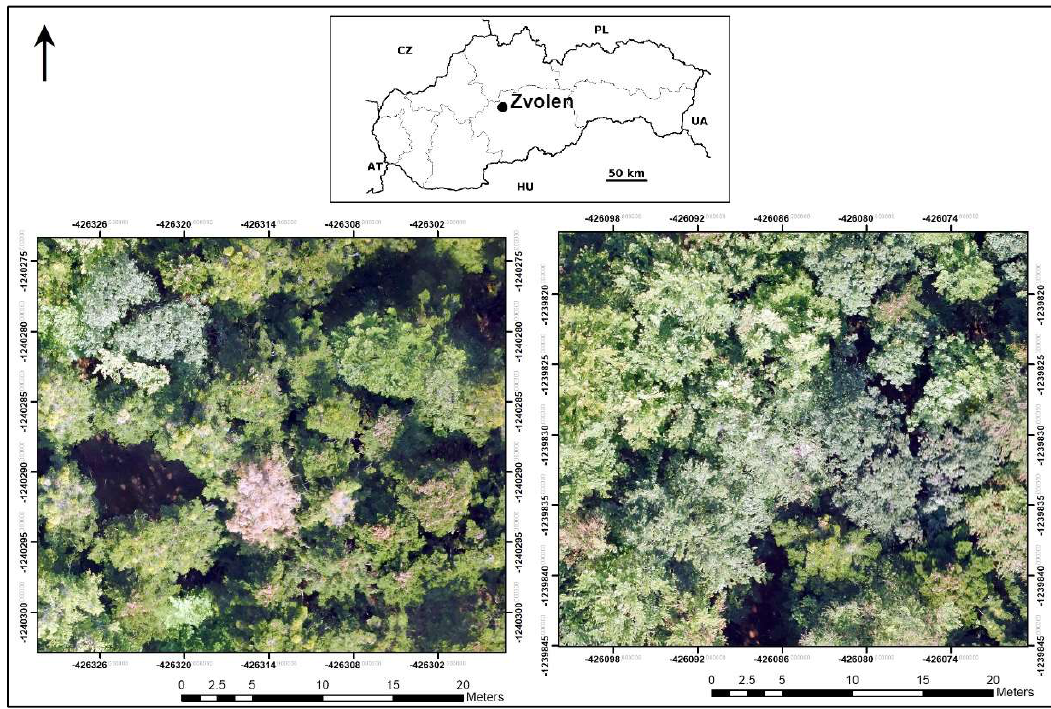
Figure 1. Location of research plots. The left is Plot1 and the right is Plot 2